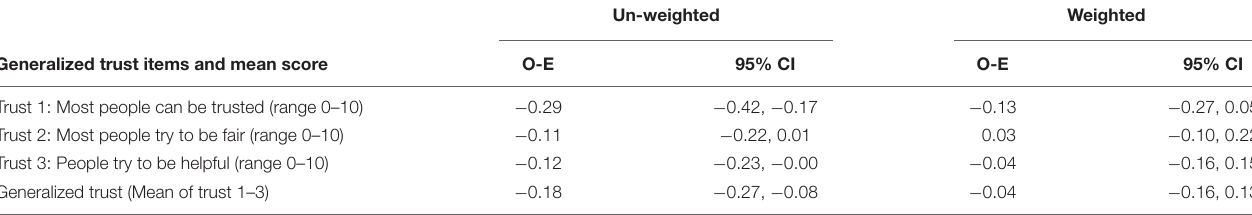
TABLE 1 | Differences between observed (O) and expected (E) generalized trust with 95% confidence intervals (CI).